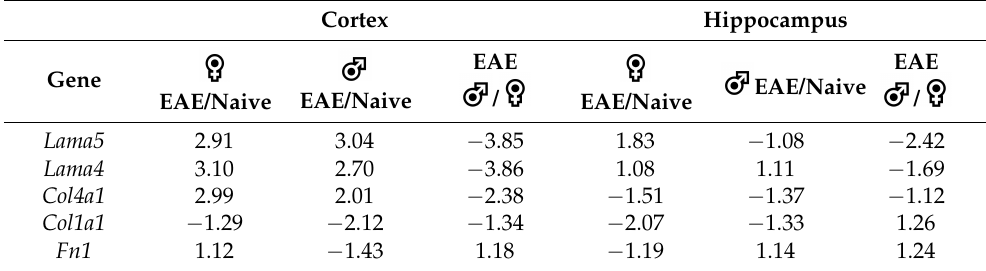
Figure 4. Sex-specific viscoelastic properties of the mouse brain in healthy conditions and EAE. ( A ) Shear wave speed c in m/s and fluidity ϕ in rad in the whole coronal midbrain. ( B ) Regional distribution of c in the hippocampus (hc), cortex and thalamic area; light red = healthy female; dark red = EAE female; light blue = healthy male; dark blue = EAE male. Representation of individual data points with mean and 95%CI. n female naive = 14, n male naive = 13, n female EAE = 21, n male EAE = 18. Two-way ANOVA with Fisher’s LSD post-hoc comparisons. ns = not significant. Table 1. Sex-specific fold changes in gene expression of ECM components in EAE compared to healthy and between EAE in cortex and